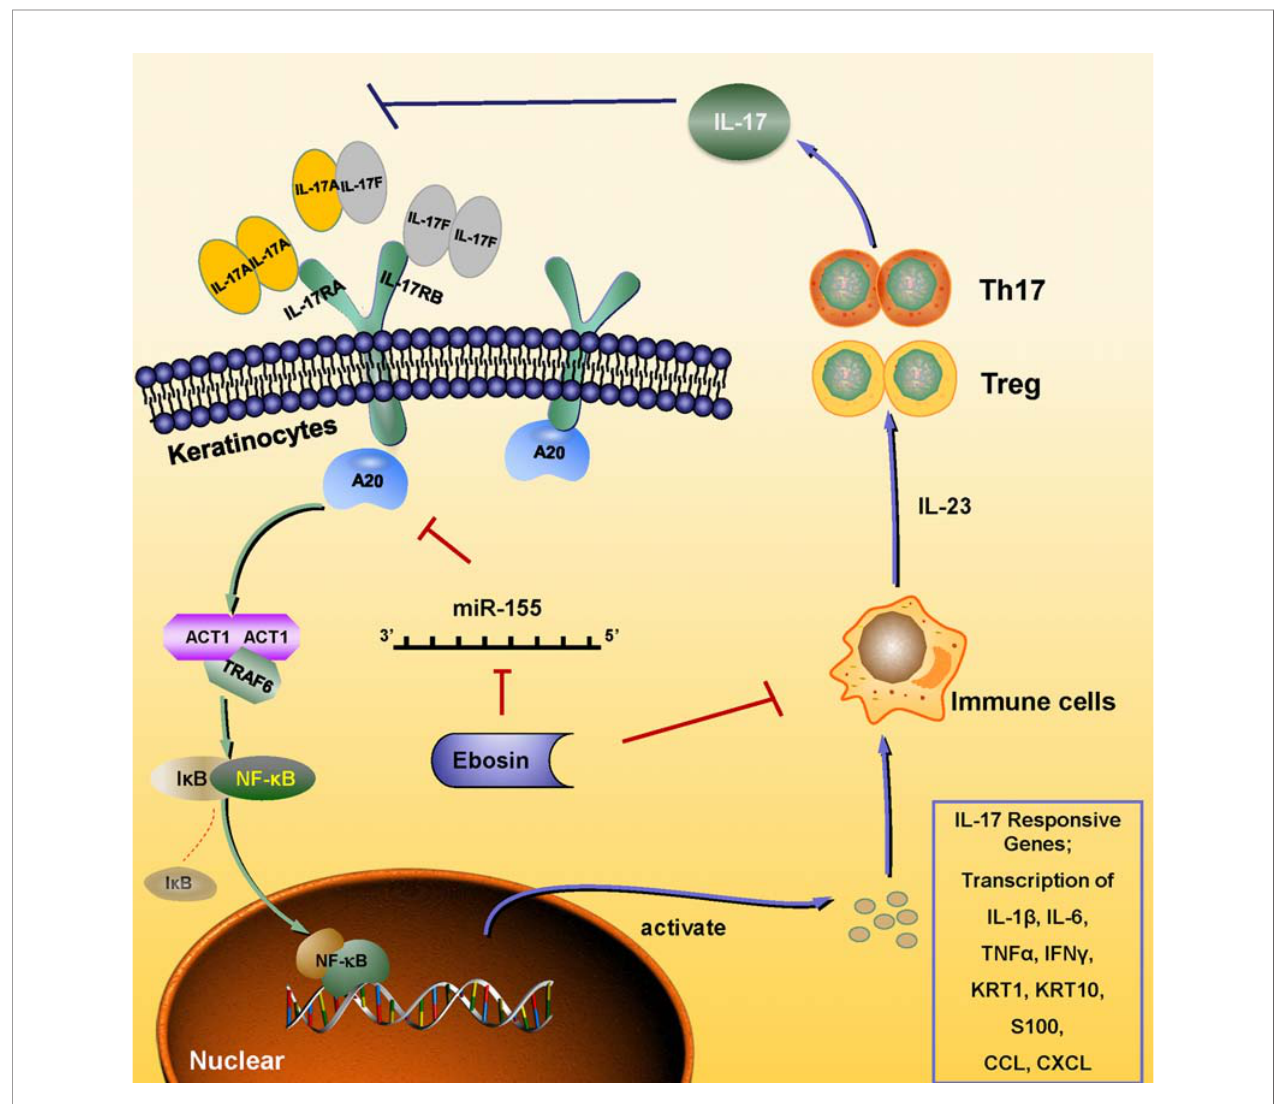
FIGURE 7 | Schematic of the mechanism underlying the Ebosin inhibition of psoriasis development. Ebosin could decrease miR-155 expression, which is responsible for the regulation of A20, leading to the balance of Treg/Th17 and the decreased secretion of in fl ammatory cytokines via inactivation of